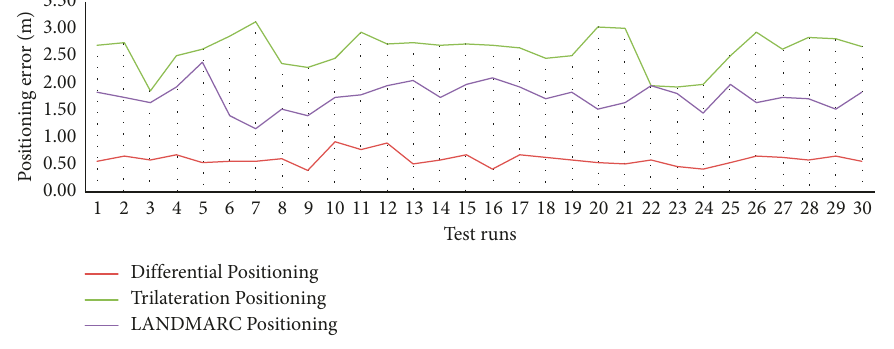
Figure 27: Positioning algorithms’ error comparative results (Bluetooth technology). Table 3: Comparative experimental results: RMSE summary statistics (RFID technology).